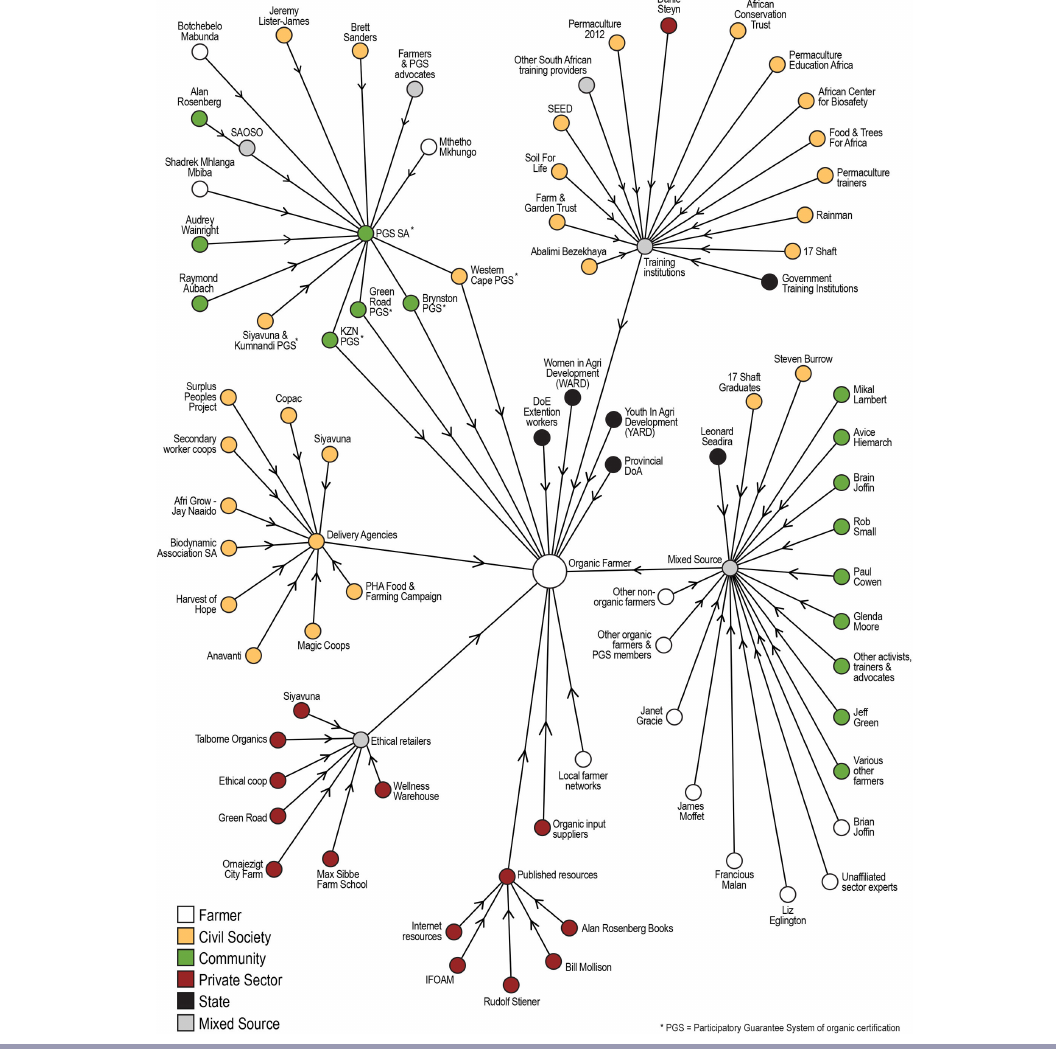
Fig. 3 . Combined network map of actors identified by sector organizations as influential information partners to